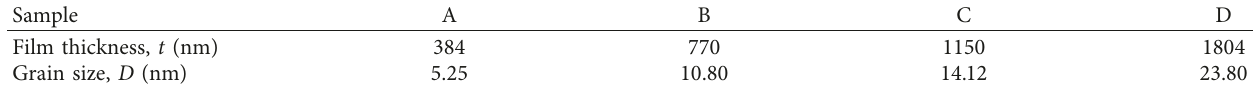
2 Te 3 thin films prepared by different deposition times at (A) 15, (B) 30,